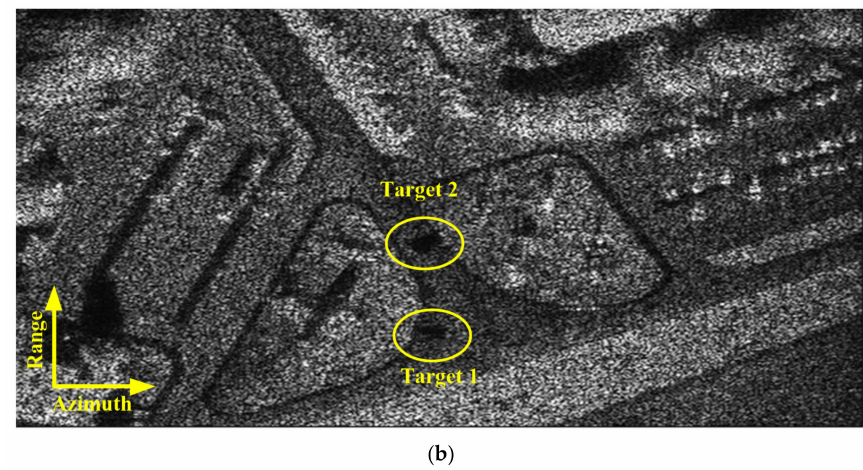
Figure 20. Simulated natural scene reconstructed by ( a ) the X-band and ( b ) Ka-band.